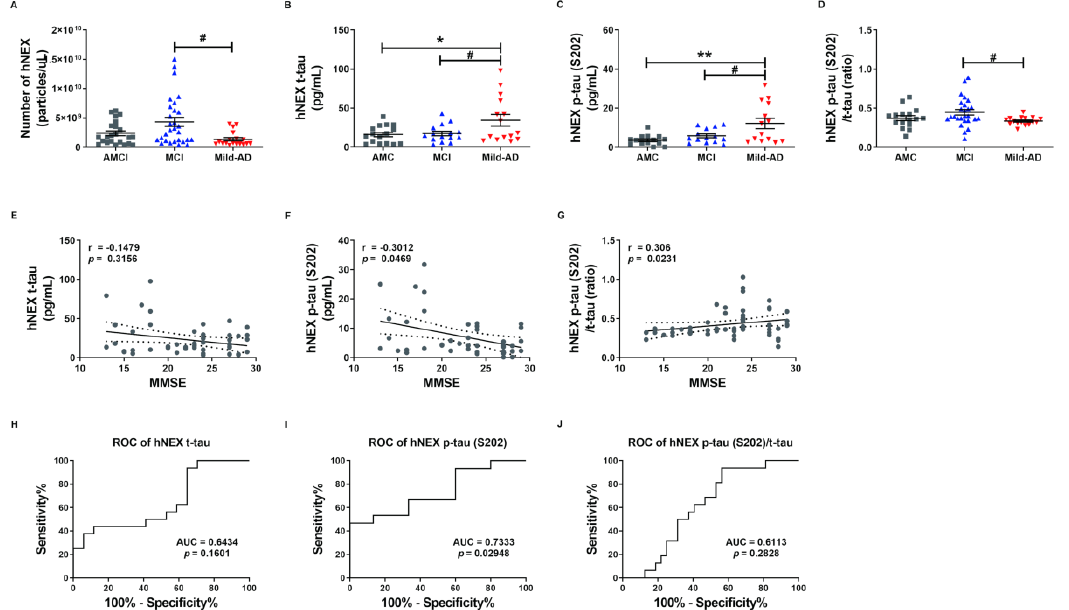
Figure 2. Serum total tau and phosphorylated tau in neuronal cell-derived exosomes are elevated according to the severity of Alzheimer’s disease. ( A ) The number of human neuronal cell-derived exosomes (hNEX) was quantified by ELISA for the exosome marker CD63. The number of hNEX was lower in the Mild-AD group than the MCI group. ( B ) Total tau (t-tau), ( C ) p-tau (S202), and ( D ) p-tau (S202) / t-tau ratio in human neuronal cell-derived exosomes (hNEX) were quantified using ELISA. hNEX t-tau and p-tau (S202) were higher in the Mild-AD group than the AMC and MCI groups. All data were shown as means ± SEM. * p < 0.05 and ** p < 0.01 compared to the AMC group and # p < 0.05 compared to the MCI group by one-way ANOVA and Holm-Sidak’s or Dunn’s multiple comparison test. Correlations of hNEX ( E ) t-tau, ( F ) p-tau (S202), and ( G ) p-tau (S202) / t-tau with MMSE scores were assessed using the nonparametric Spearman’s rank correlation test. Graphs show regression lines with 95% confidence intervals. hNEX p-tau (S202) and p-tau (S202) / t-tau were significantly correlated with MMSE scores. ROC analyses of hNEX ( H ) t-tau, ( I ) p-tau (S202), and ( J ) p-tau (S202) / t-tau indicating moderate diagnostic accuracy of elevated hNEX p-tau (S202). AUC, area under the